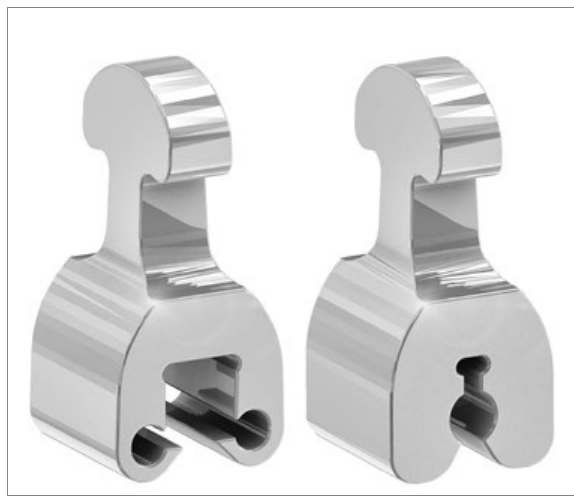
Figure 1. The nickel titanium Trillium Compression Hooks for rectangular (left) and round (right) arch Table I. Available dimensions of compression hooks for round, square, and rectangular wires.